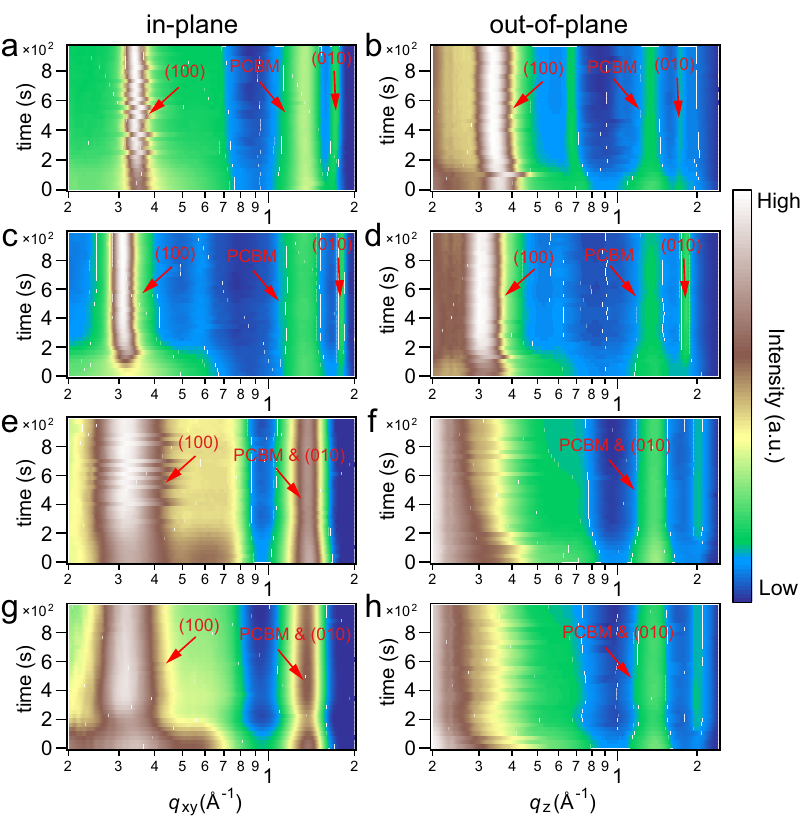
Fig. 2 In situ grazing-incidence wide-angle X-ray scattering (GIWAXS). In situ GIWAXS in-plane and out-of-plane pseudo color mapping plots of a , b DR3TSBDT:PC 71 BM, c , d DTS(PTTh 2 ) 2 :PC 71 BM, e , f DPPEZnP-TEH:PC 61 BM and g , h DPPEZnP-TEH:PC 61 BM/Py (scattering data was collected every 30 s with 2 s exposure